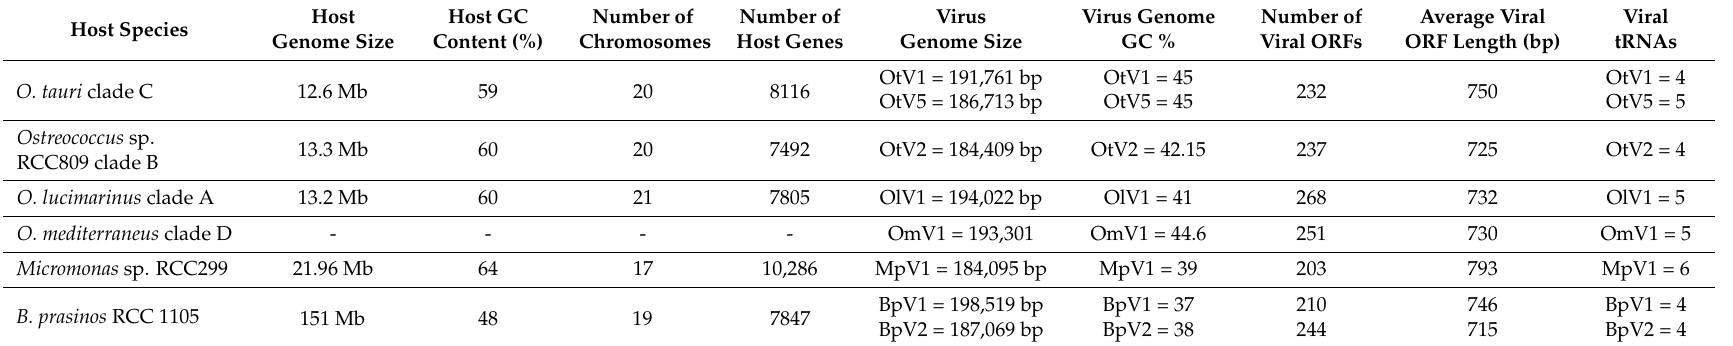
Table 1. Key features of characterised prasinophytes and their